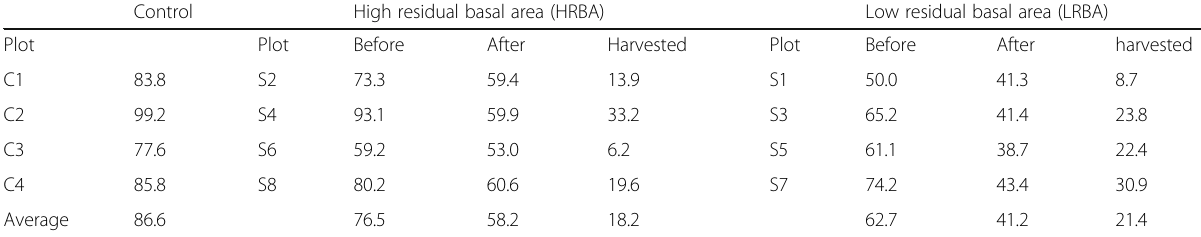
Table 1 Basal area (m 2 ha − 1 ) per treatment and plot before (2012) and after the harvesting (2014)